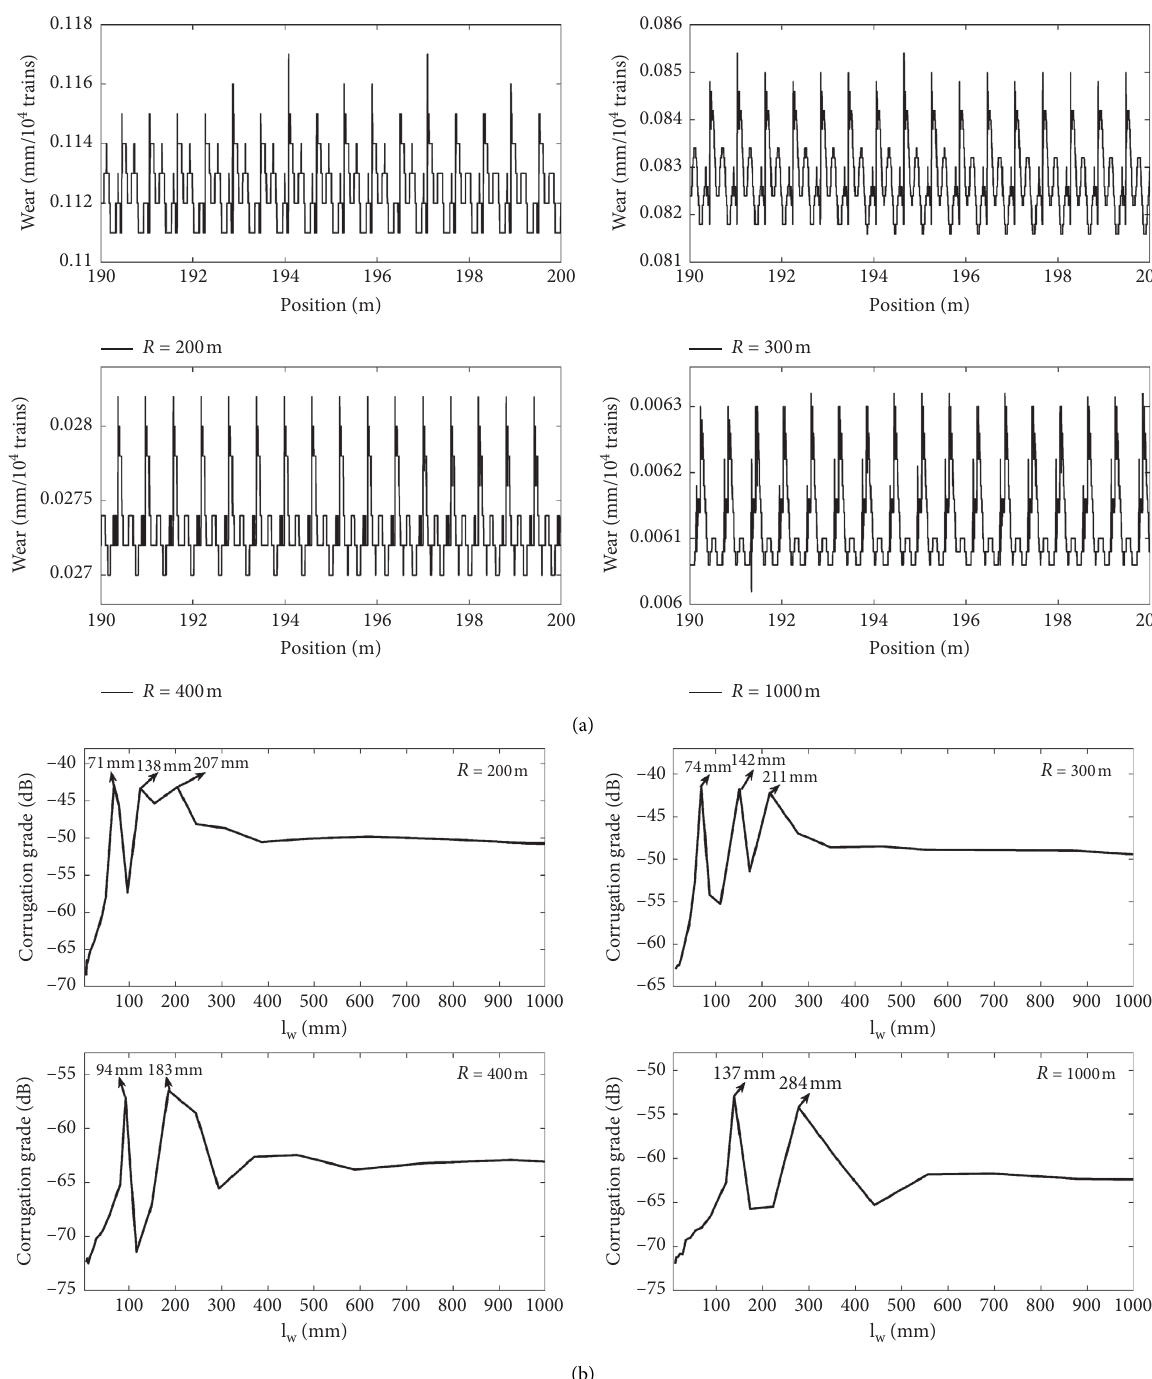
Figure 8: Time-frequency analysis curve of rail wear in curves with different radii. (a) Rail wear of curved track with different radius. (b) One-third octave spectrum curve of rail